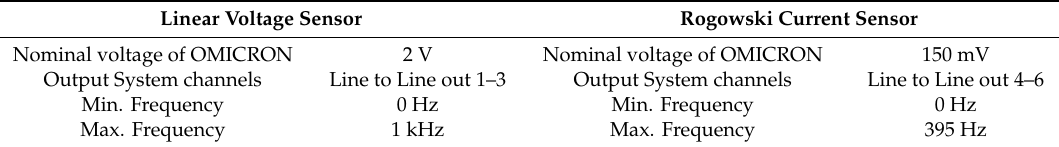
Figure 6. Wiring of CMLIB A. Table 3. CMLIB A Hardware Configuration